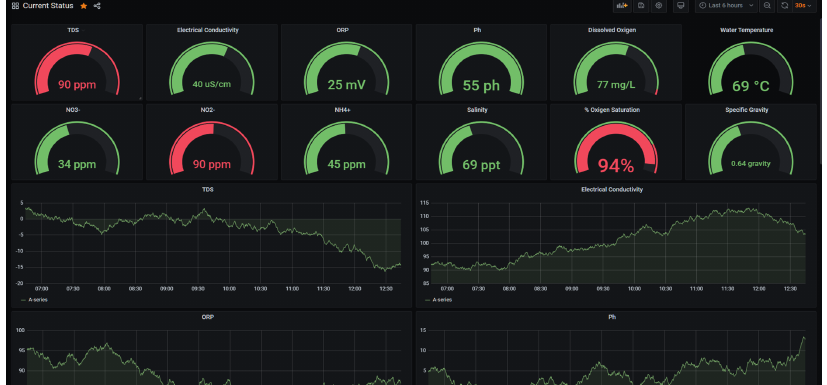
Figure 13. Graphical interface on